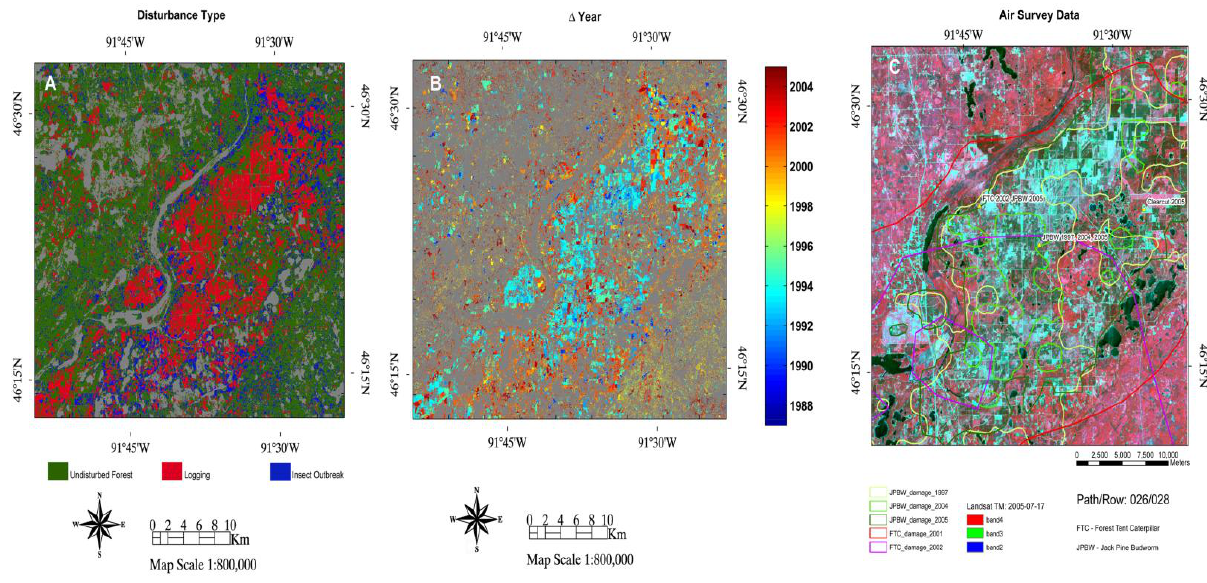
Figure 10. Example of disturbance classification evaluation and change results for a